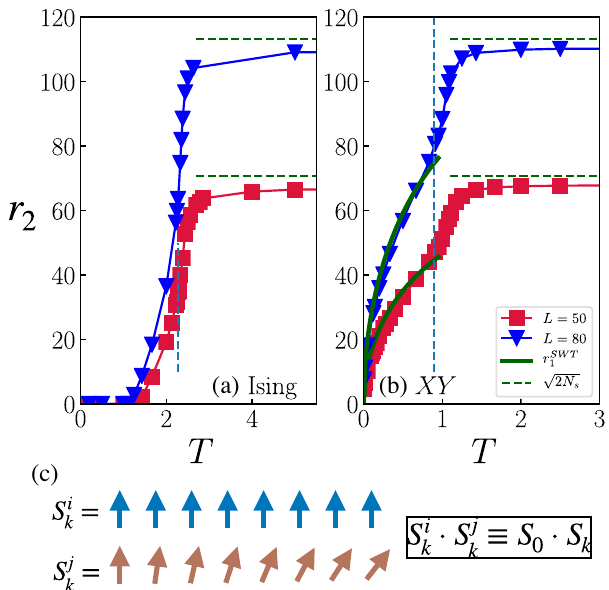
FIG. 9. Correlation functions and distance between neighbor- ing configurations. Temperature dependence of the smallest r 2 (this distance is representative of the lowest value of μ , see text) for the (a) Ising and (b) XY models. The lines (solid and dashed) represent the predictions for r 2 based on Eq. (14) and the corresponding expressions of the asymptotic formula for the correlation functions in the high- and low-temperature regimes (see text). Panel (c) illustrates the basic assumption behind Eq. (14); i.e., correlations between configurations are equivalent to correlation functions (see